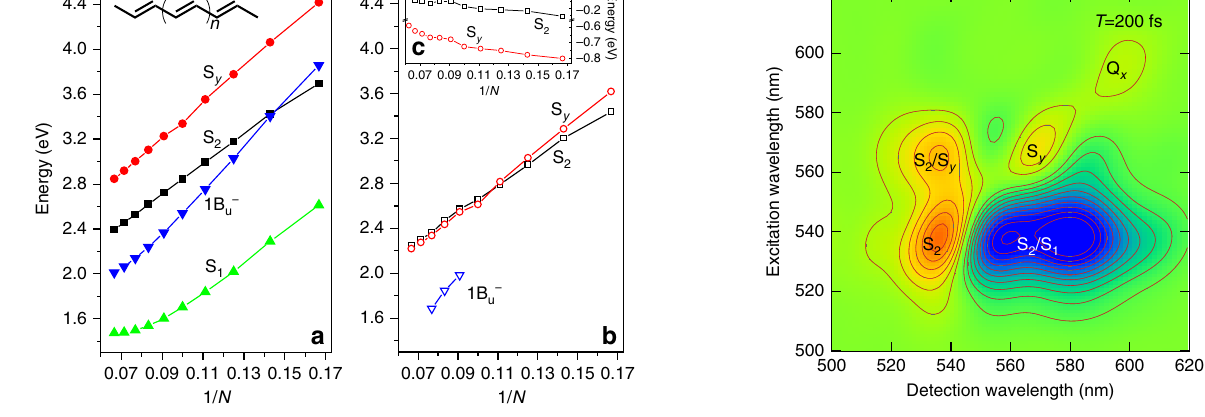
Fig. 5 Dependence of excitation energies of polyenes on the conjugation length N . a At the ground-state geometry. b At the S 2 state potential minimum geometry. c The energy shifts of the S 2 and S y states from the ground-state geometry to the S 2 state potential minimum geometry.